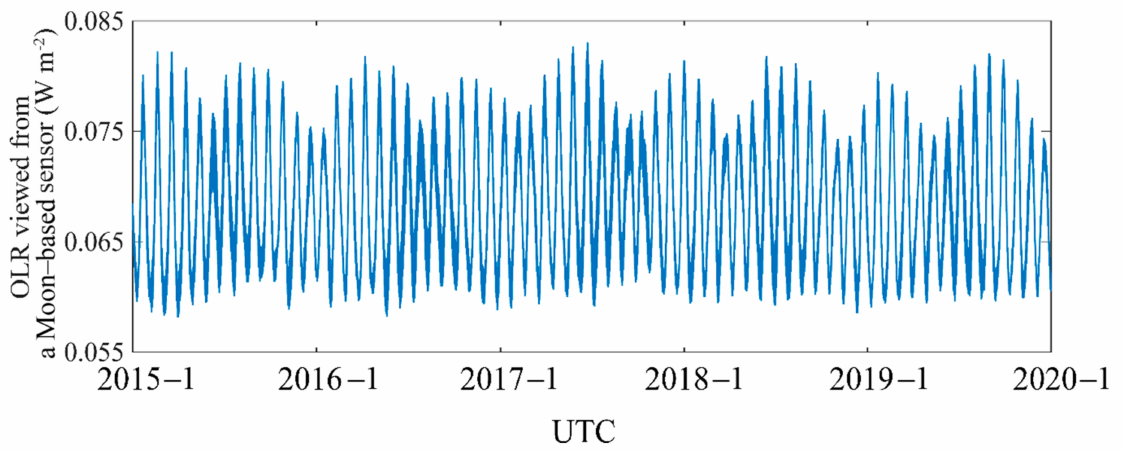
Figure 6. Variation of Moon-based outgoing long-wave radiation (OLR) measurements.